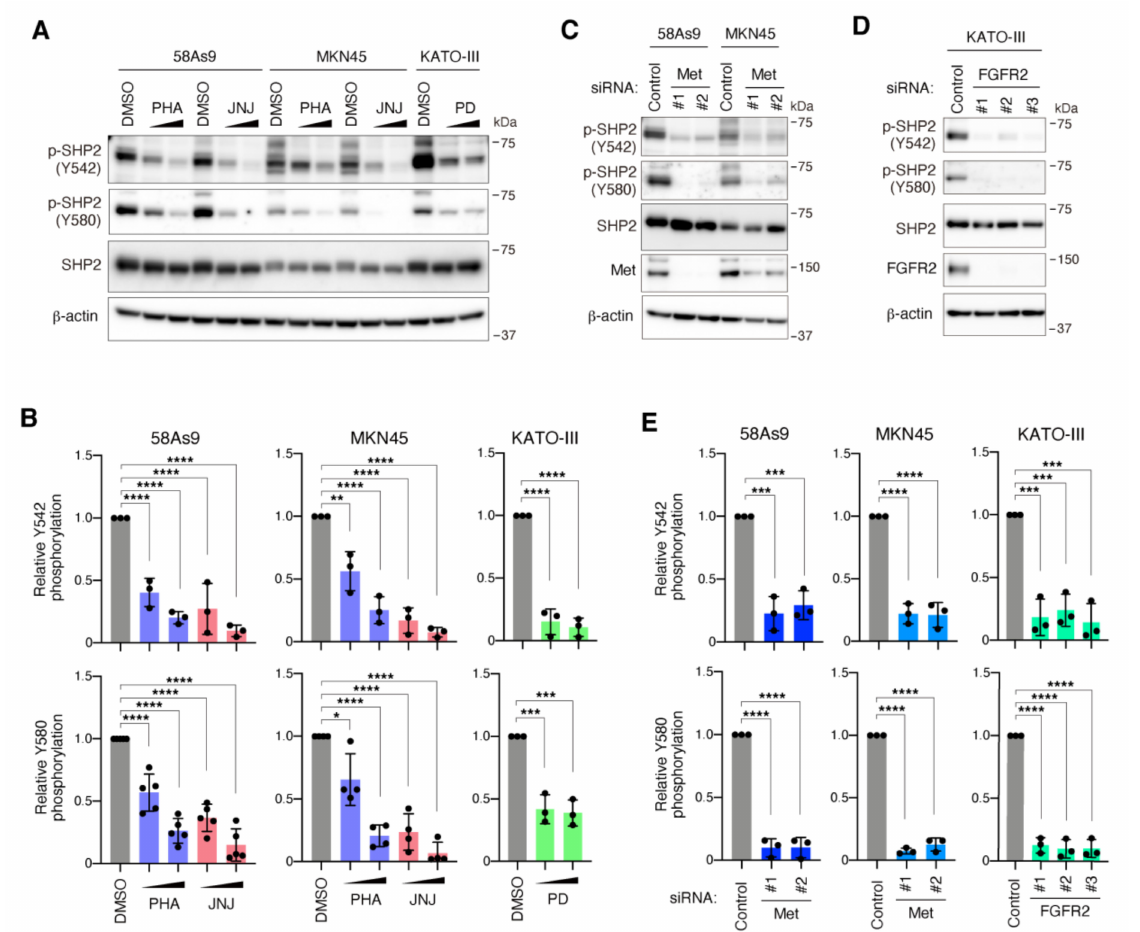
Figure 2. SHP2 is tyrosine-phosphorylated downstream of amplified Met and FGFR2 in DGC cells. ( A ) Immunoblot analysis of 58As9 and MKN45 cells treated with Met inhibitors PHA-665752 (PHA) and JNJ-38877605 (JNJ), and of KATO-III cells treated with the FGFR inhibitor PD-173074 (PD), at 100 or 300 nM for 2 h. ( B ) Quantitative analysis of immunoblot data for SHP2 phosphorylation in cells treated with inhibitors. Bars, SD ( n = 5 for 58As9 Y580, 4 for MKN45 Y580, and 3 for others). *, p < 0.05; **, p < 0.01; ***, p < 0.001; ****, p < 0.0001. ( C ) 58As9 and MKN45 cells were transfected with control or Met siRNAs and subjected to immunoblot analysis. ( D ) KATO-III cells were transfected with control or FGFR2 siRNAs and subjected to immunoblot analysis. ( E ) Quantification of SHP2 phosphorylation in cells transfected with siRNAs. Bars, SD ( n = 3). ***, p < 0.001; ****, p <